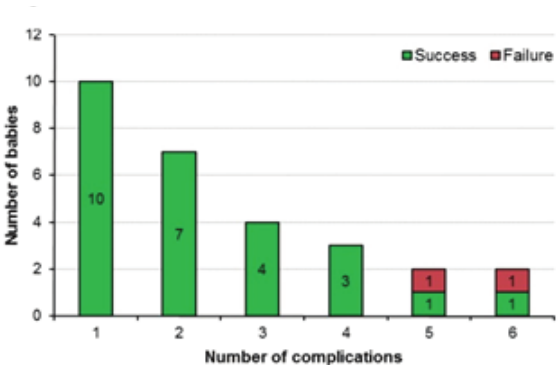
Figure 4. Stacked bar chart showing number of babies according to number of risk